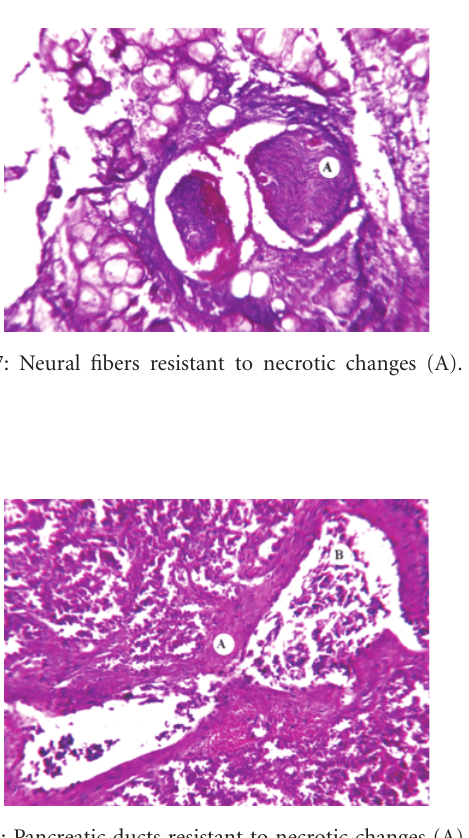
Figure 6: Fresh massive diapedesis (hemorrhages) in pancreas with ANP. Masson staining ( × 100).